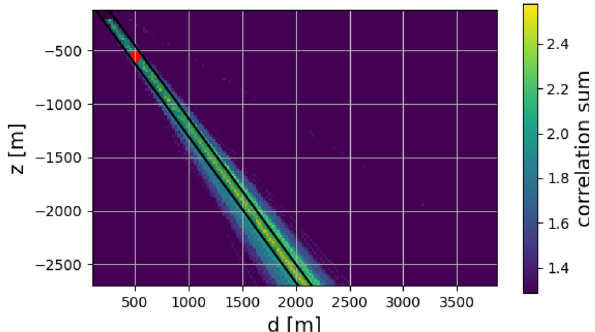
Fig. 5 Scan to restrict the vertex search volume. Results are projected in the horizontal distance v. depth plane, with the colors showing the maximum correlation sum over all azimuths. The black lines mark the volume in which the finer scan will be performed. The red dot marks the true vertex position